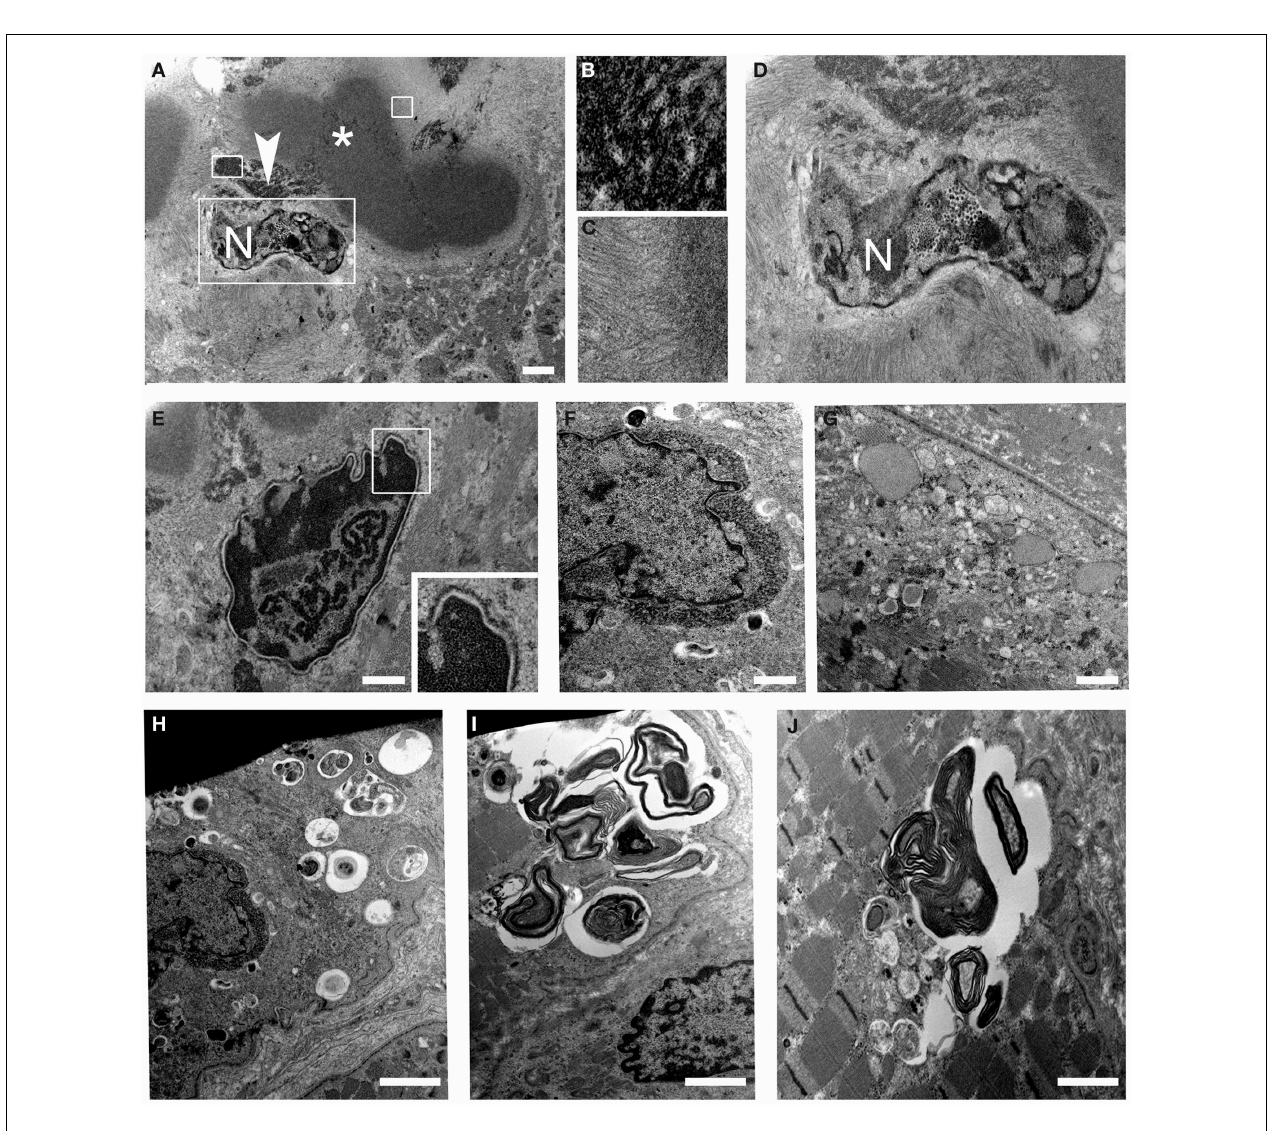
accumulated at the nuclear rim. (G) Images showing dilated sarcoplasmic reticulum filled with amorphous material in a myofiber. (H–J) Images showing autophagic vacuoles and myelin figures close to nuclei and throughout some sarcomeres of muscle fibers. Scale bar,